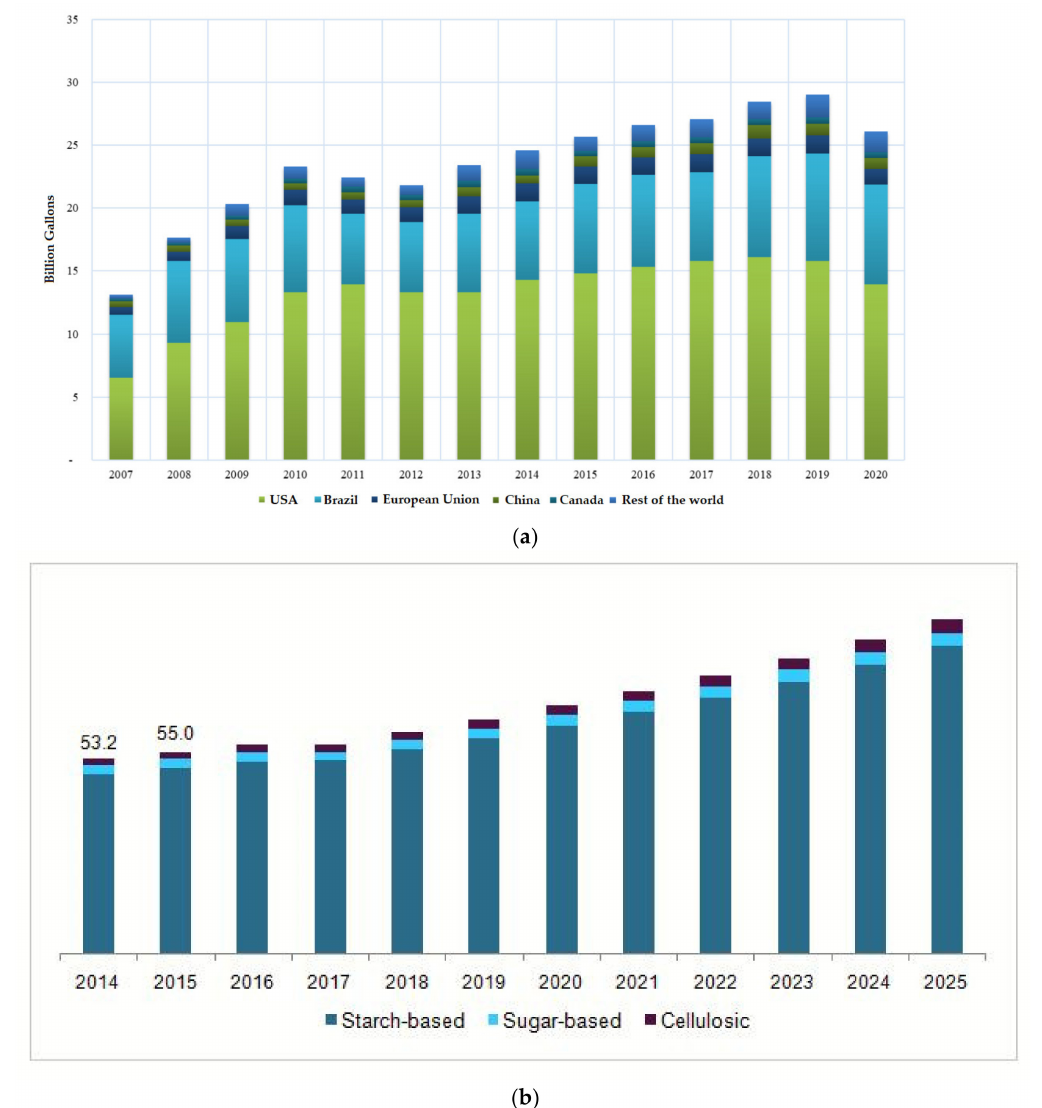
Figure 1. ( a ) Global bioethanol production by country or region. ( b ) U.S. fuel ethanol market volume by product, 2014–2025 (Billion Litres). Accessed data from afdc.energy.gov/data (accessed on 11 June